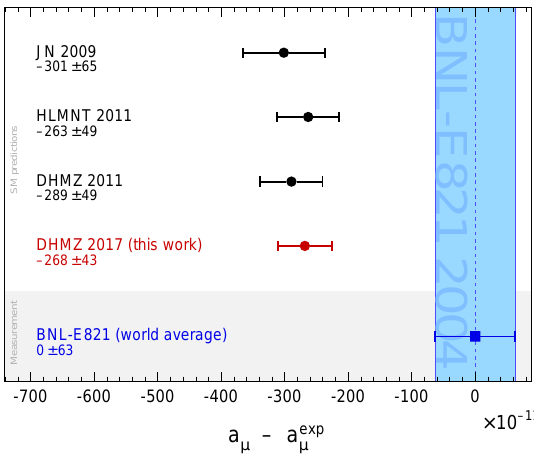
Figure 1. Compilation of recent results for a SM (in units of 10 − 11 ), subtracted by the central value of the ex- µ perimental average. The shaded vertical band indicates the experimental uncertainty. The representative SM predictions are taken from JN 2009 [18], HLMNT 2011 [19], DHMZ 2011 [3], and DHMZ 2017 [1].